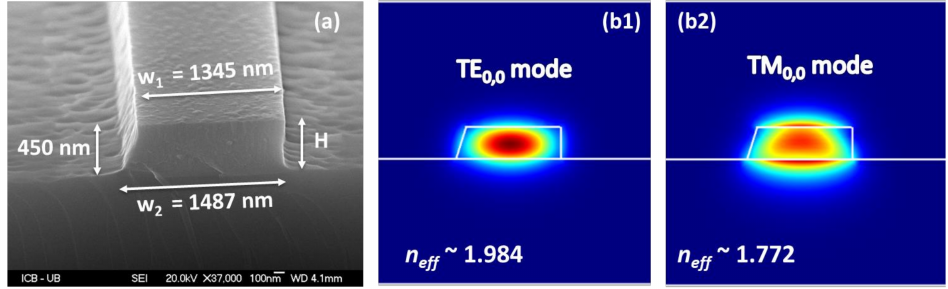
Figure 1. ( a ) Scanning Electron Microscope image of the cleaved strip TiO 2 waveguide ( b1 , b2 ) Corresponding mode profiles at 1640 nm and associated effective index for the first transverse electric (TE) and transverse magnetic (TM)